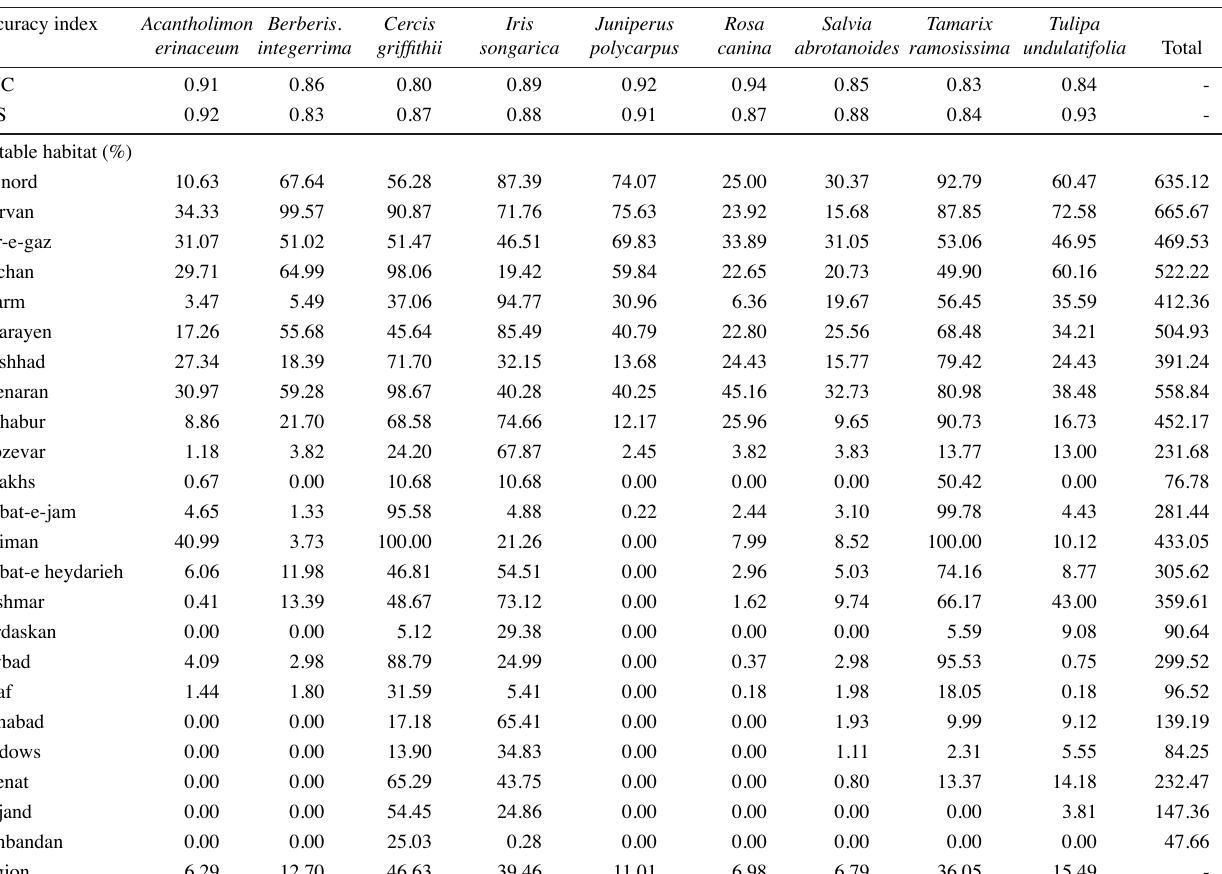
Tab. 3: Studied plant species’ suitable habitats and results of model evaluation (TSS: True Skill Statistic for evaluating the model, AUC: Area Under Curve for MaxEnt). Accuracy